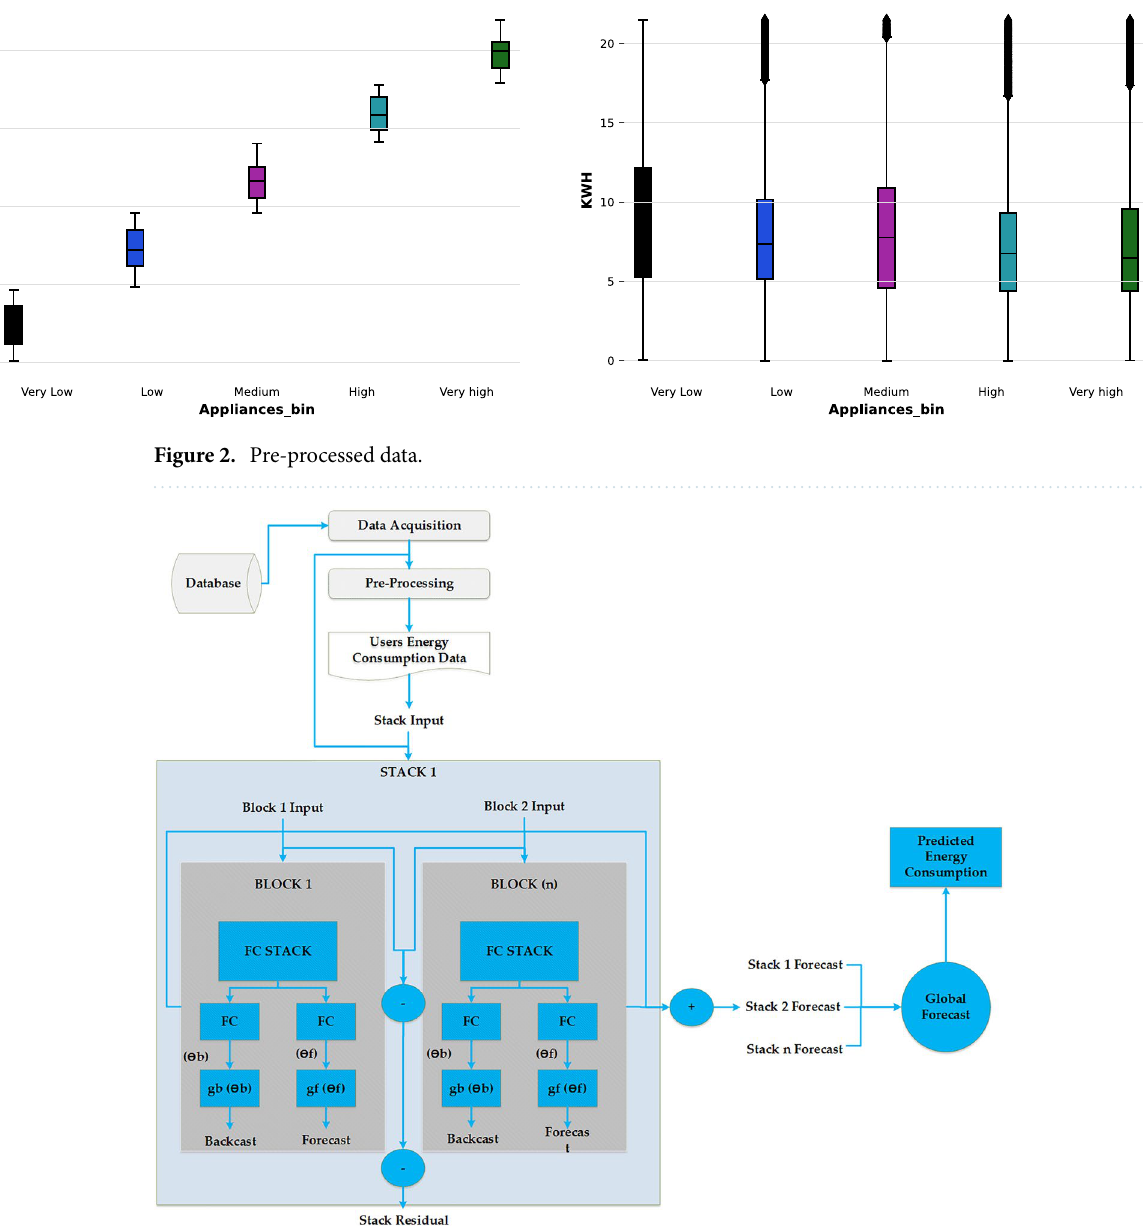
Figure 3. Proposed N-BEATS interpretable